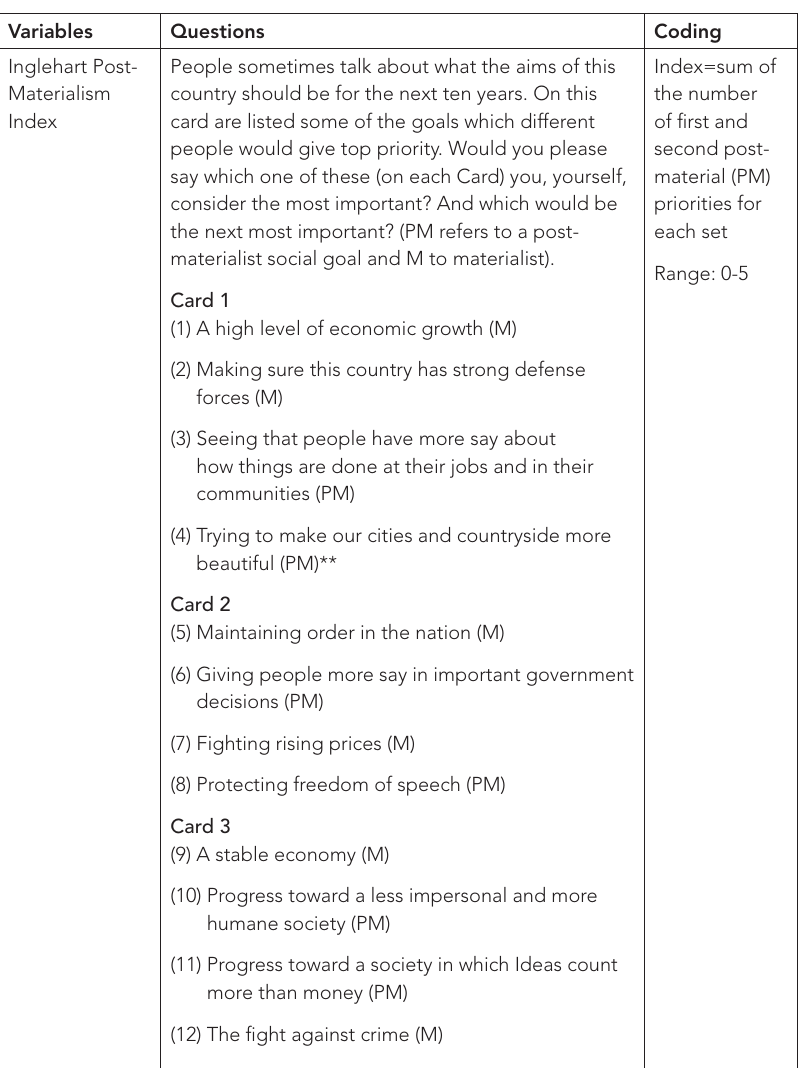
Table 1. World Values Survey Wave 6 * Questions Wording and Coding Variables